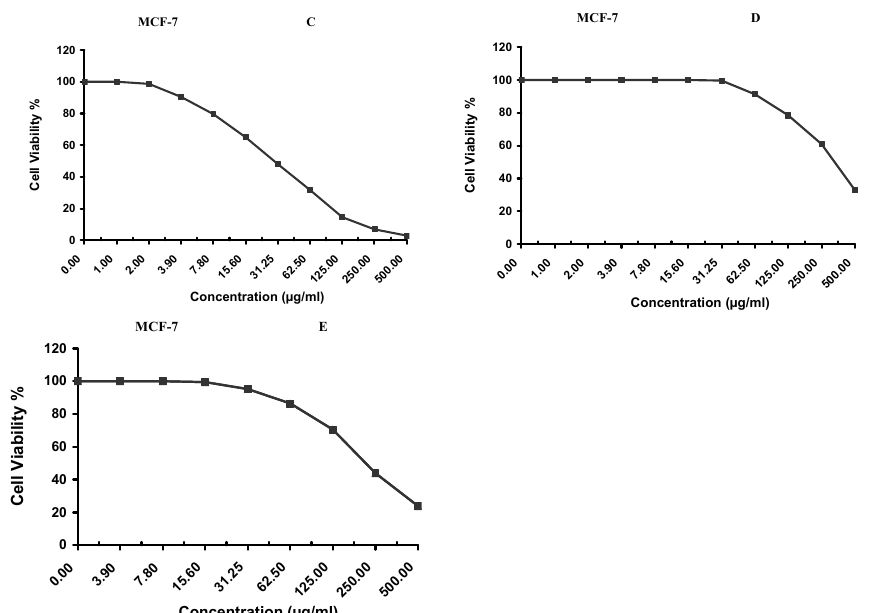
Figure A2. The percentage of cell viability of breast cancer cell lines (MCF-7) upon treatment with different doses of the test samples. ( A ) the unloaded PLGA NPs, ( B ) the PLGA-Cf-F 1 NPs, ( C ) the PLGA-Cf-F 2 NPs and ( D ) the PLGA-Cf-F 3 NPs. Finally, graph ( E ) is for the free coffee extract.